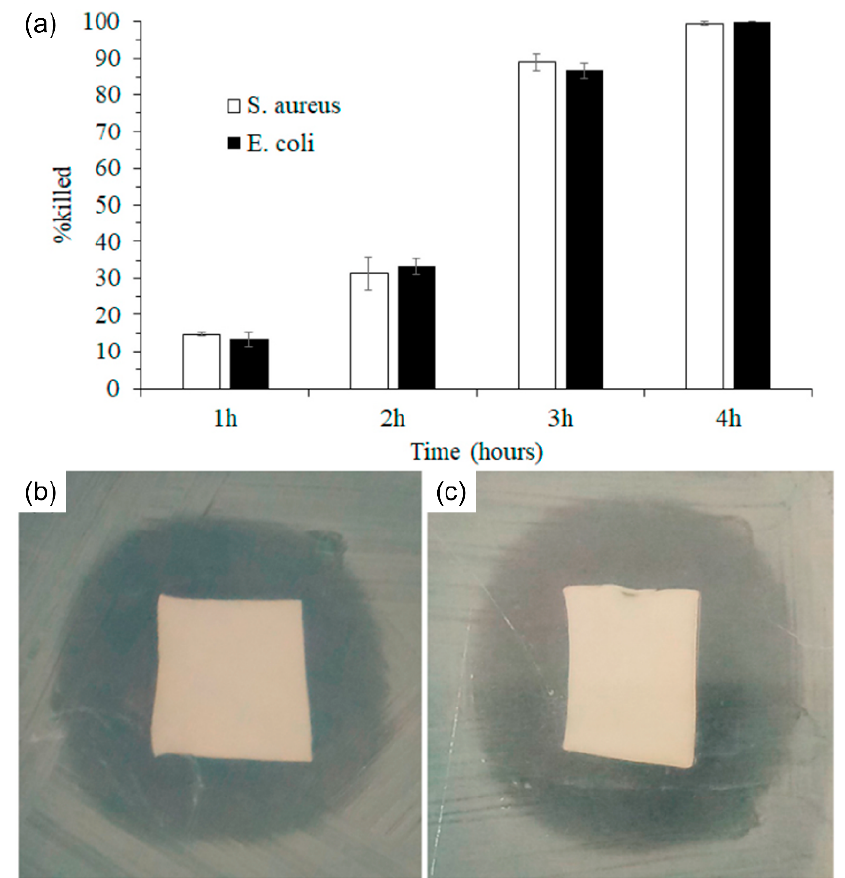
Figure 13. ( a ) Antibacterial activity of PVA/PAA10*-C samples against S. aureus and E. coli and inhibition zone of PVA/PAA10*-C samples against ( b ) E. coli and ( c ) S. aureus . Reproduced with permission from [96], Copyright © 2021, Elsevier.